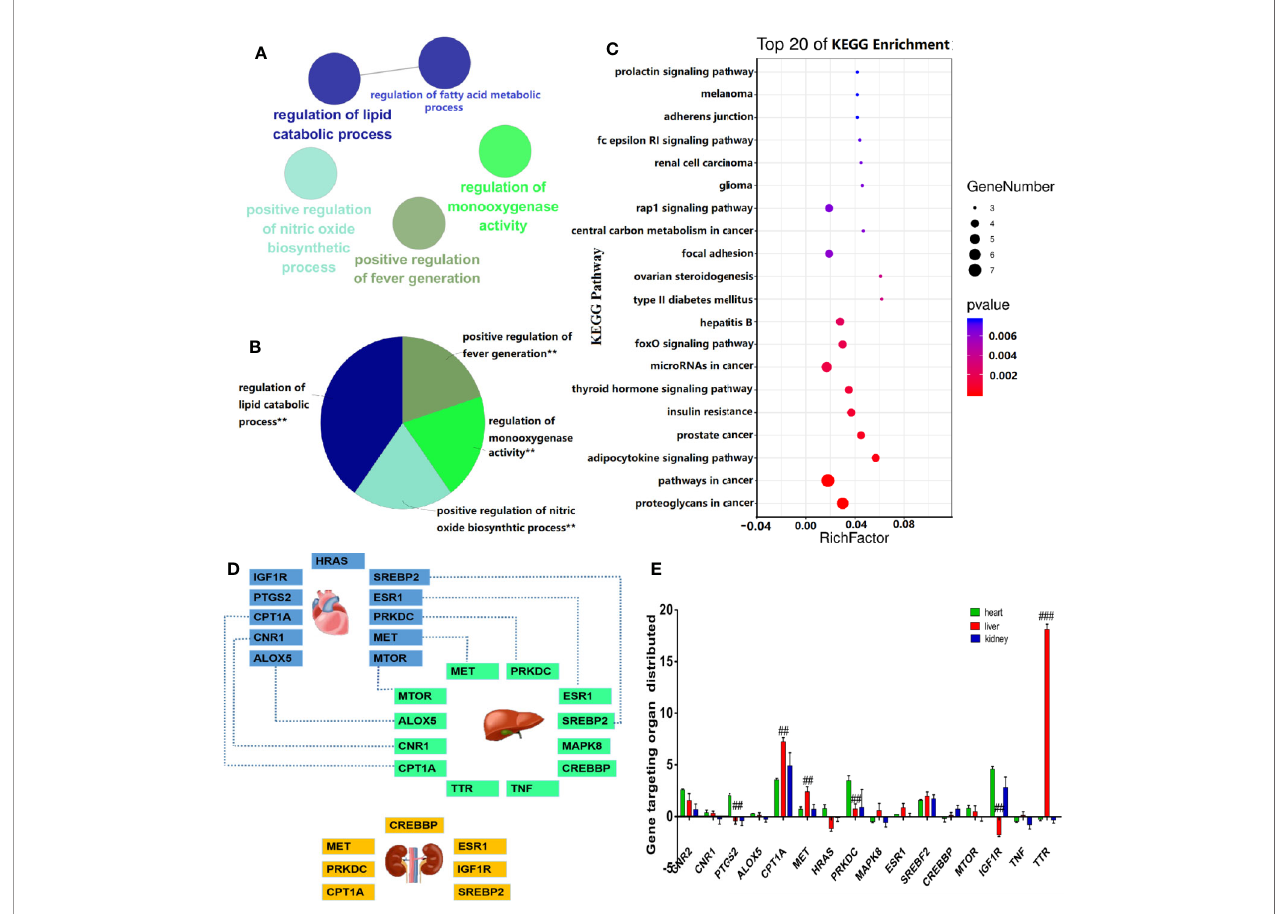
FIGURE 3 | Bioinformatics analysis and localization analysis of key targets. (A) Gene ontology (GO) enrichment analysis of the hierarchical network diagram. (B) GO biological process enrichment analysis. (C) Enrichment analysis of Kyoto Encyclopedia of Genes and Genomes (KEGG) annotation signaling pathway. (D) Targeted organ localization analysis network. (E) The key gene expression in different tissues and organs ( ## P < 0.01, and ### P < 0.001, liver vs . control heart or